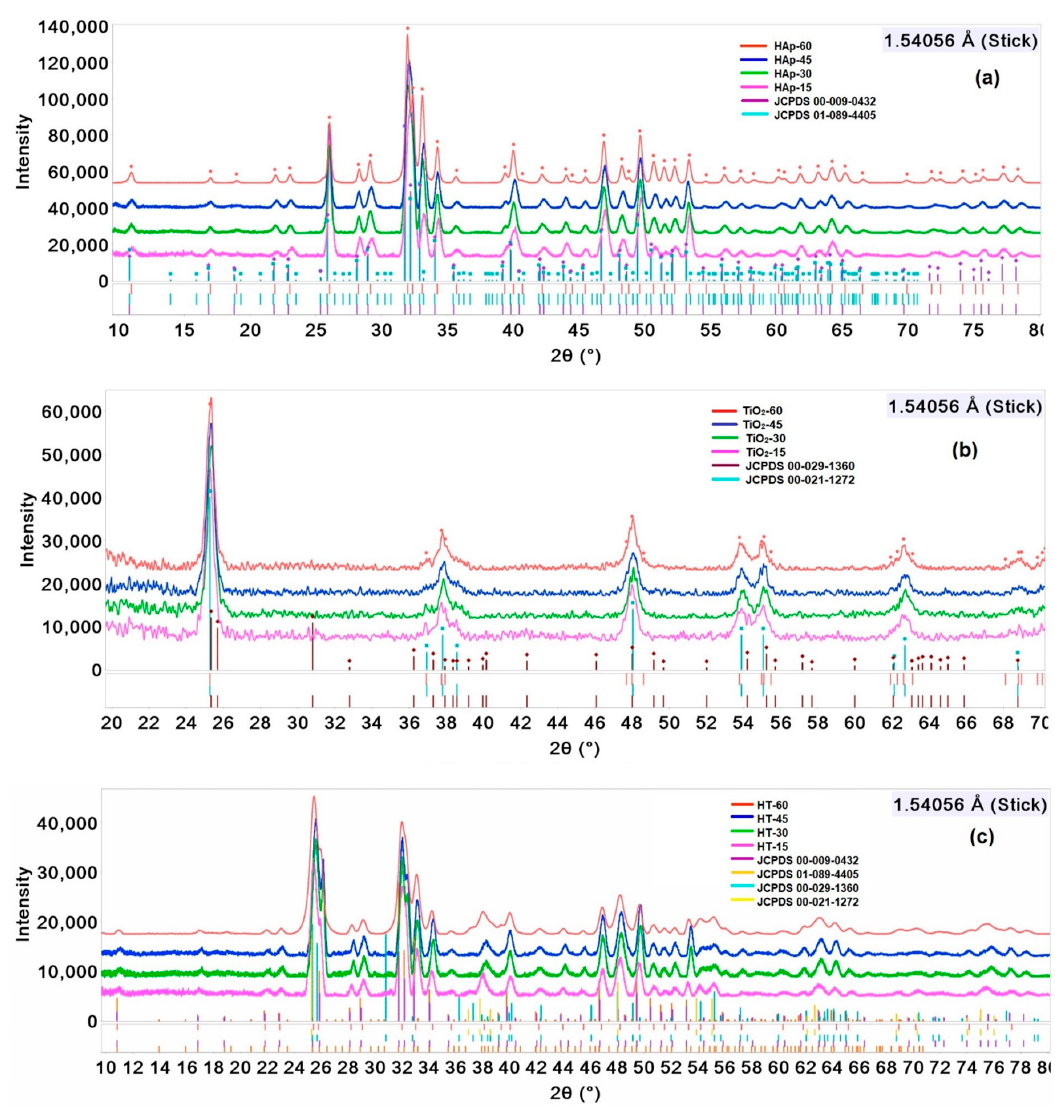
Figure 2. X-ray powder diffraction patterns for the different time intervals of ultrasound irradiation (15, 30, 45 and 60 min) and the JCPDS obtained from the Powder Diffraction File (PDF)-4+2018 database corresponding to the International Centre of Diffraction Data (ICDD) for ( a ) HAp, ( b ) TiO 2 , and ( c )